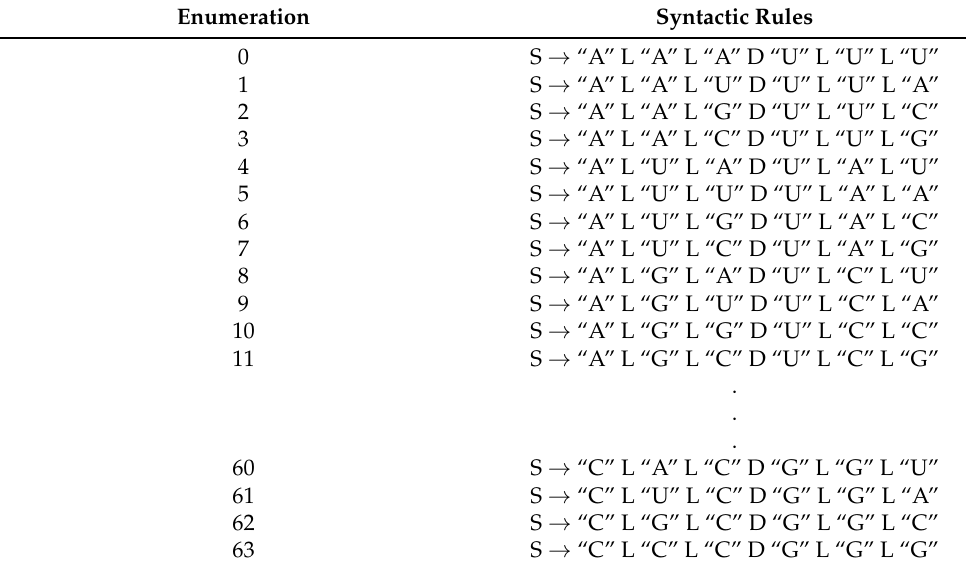
Table 1. Syntactic rules G Lpseudo